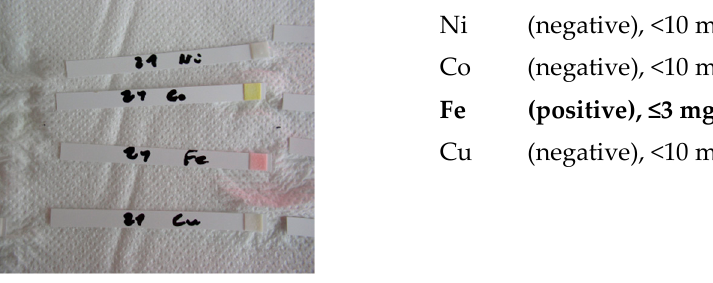
Figure 16. Screening test. Black ceramic watch band.